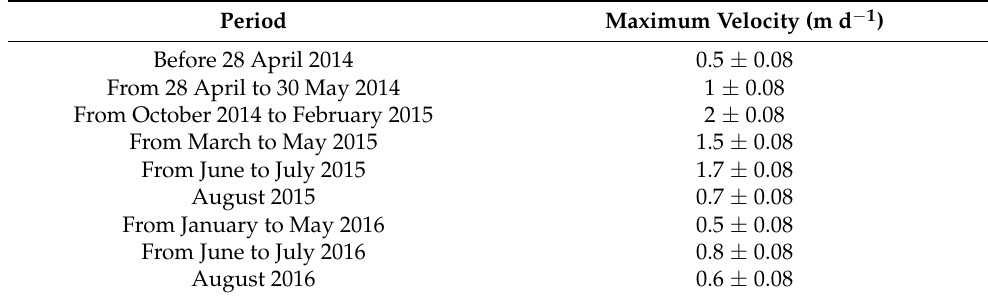
Table 2. Maximum velocity of glacier flow before and after the surge in 2014–2016.